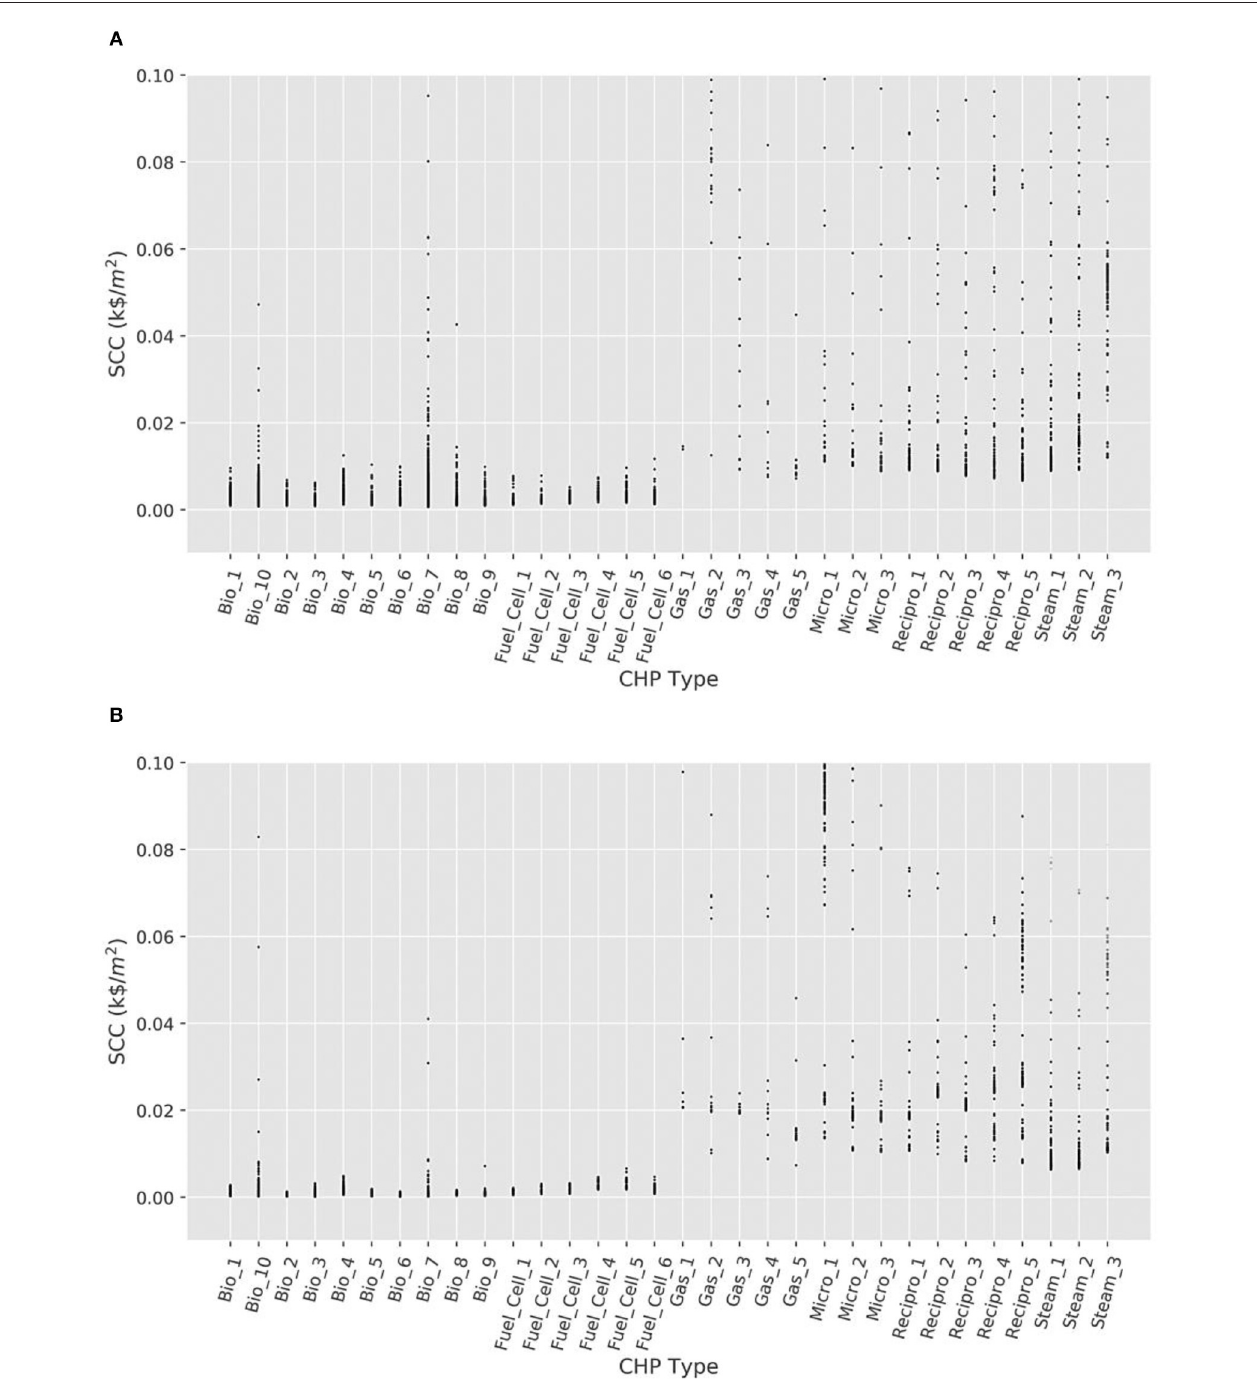
FIGURE 7 | Social cost of carbon vs. CHP type for (A) scenario 1 and (B) scenario 2, across all individual neighborhoods with SCCs less than 0.1 k$/m 2 . Each neighborhood is represented by a single dot in the plot.